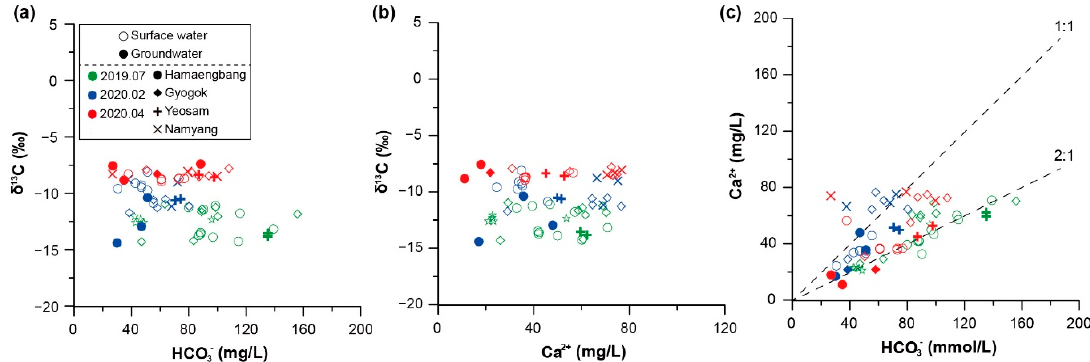
Figure 5. Scatter plots representing the hydrochemical trends ( a ) δ 13 C vs. HCO 3 − ; ( b ) δ 13 C vs. Ca 2+ ; and ( c ) Ca 2+ vs. HCO 3 − .